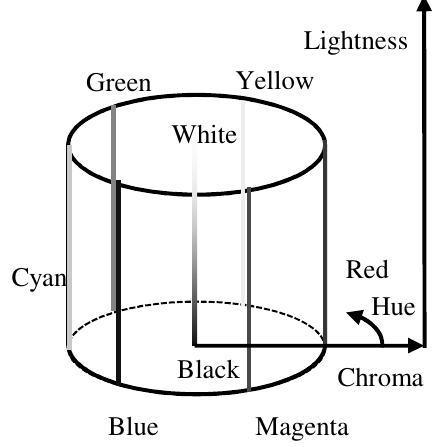
Figure 2. HSI color space with cylindrical coordinate